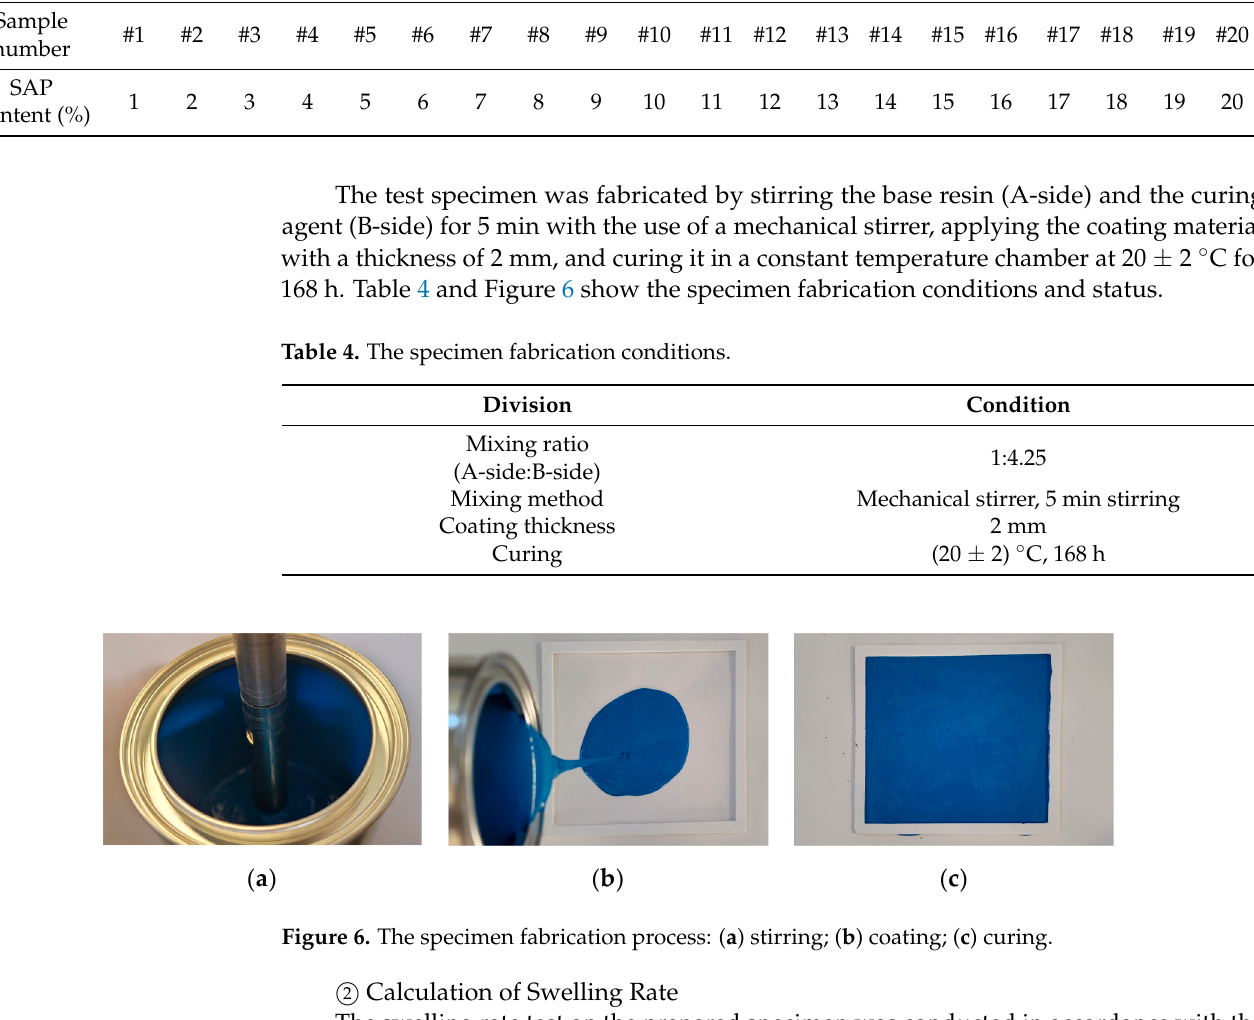
( b ) Figure 7. The swelling rate test status: ( a ) Initial volume measurement ; ( b ) Volume measurement after expansion.